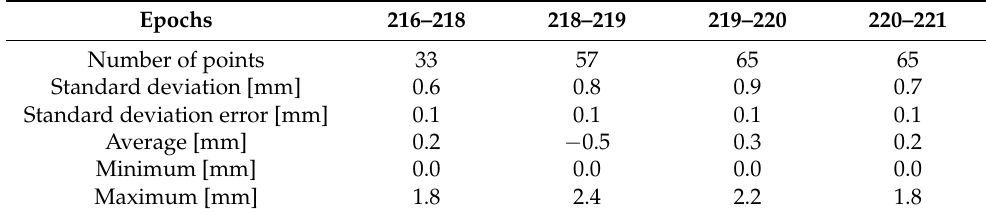
Table 6. Statistical parameters for residuals for BEAM